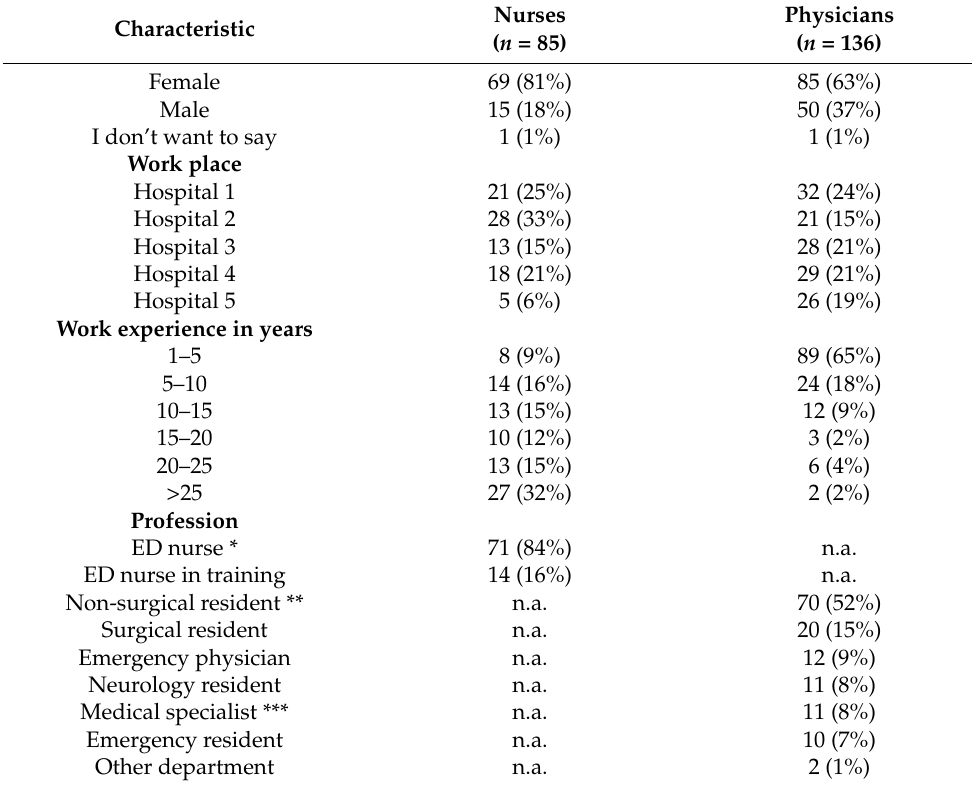
Table 1. Participant